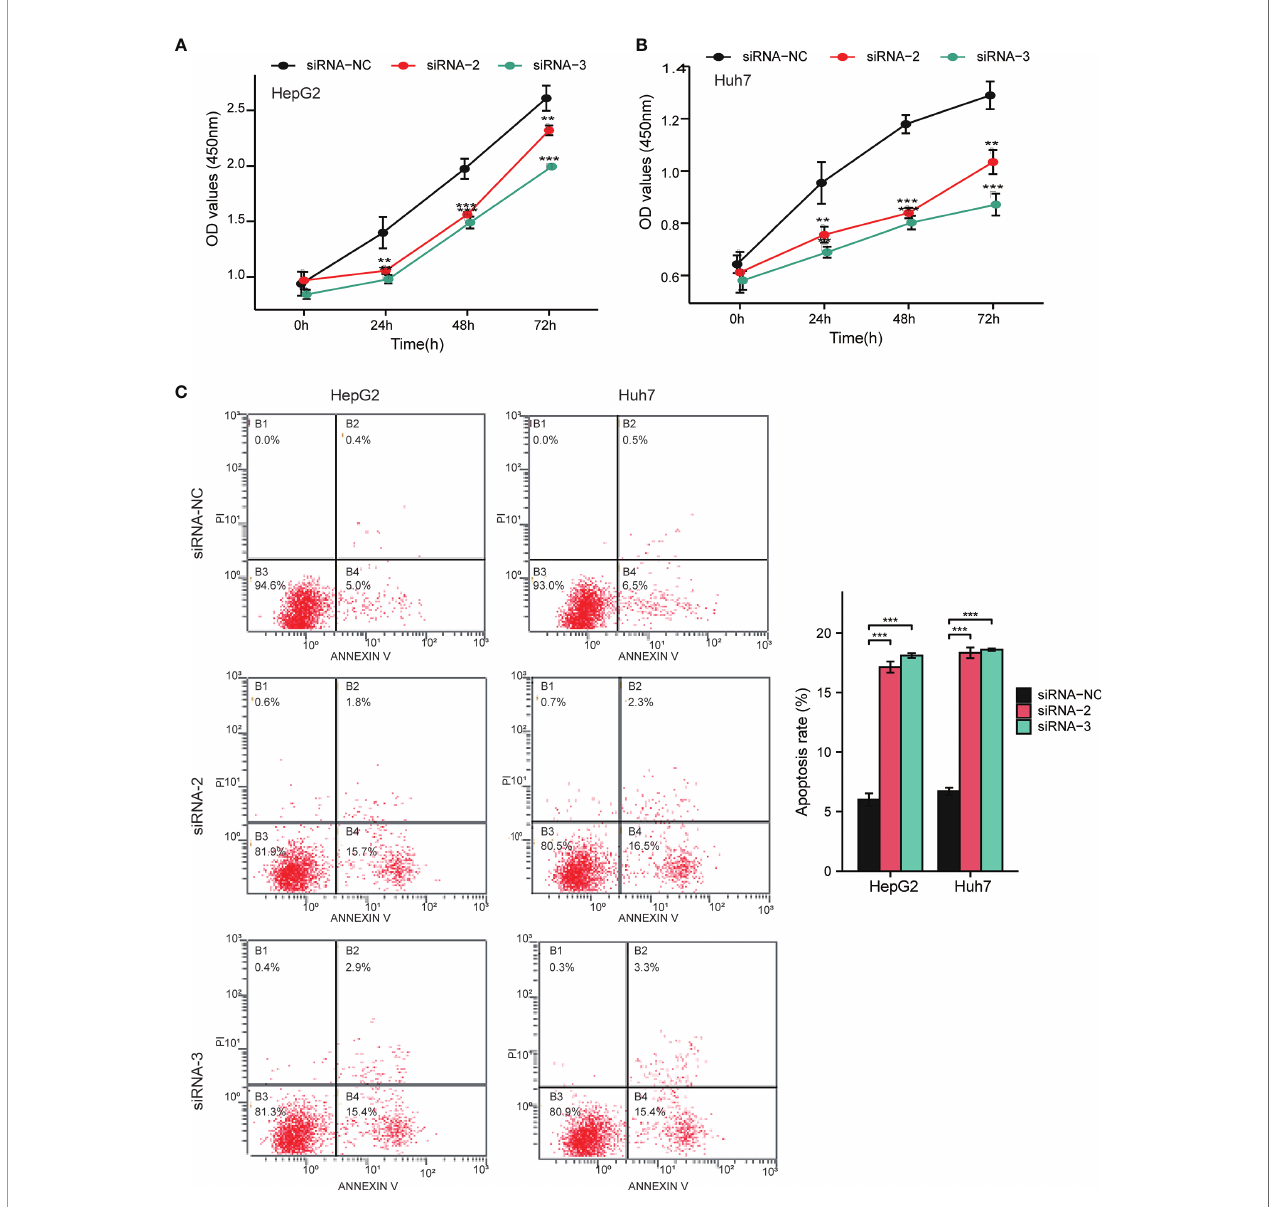
FIGURE 10 | Detection of cell proliferation and cell apoptosis by CCK-8 assay and fl ow cytometry assay. (A, B) Cell proliferation in HepG2 and Huh7 cells determined by CCK-8 assay. (C) Cell apoptosis in HepG2 and Huh7 cells determined by fl ow cytometry assay. Data were shown as mean ± standard deviation of three technical replicates. **p < 0.01, ***p < 0.001 compared to